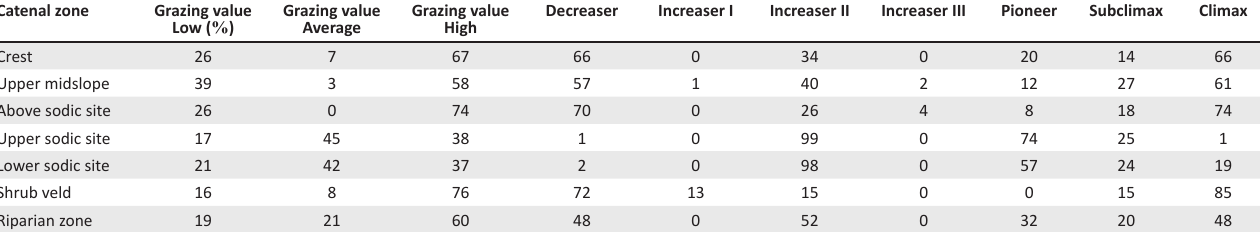
TABLE 3: Contribution ( % ) of grass species present on 100 m point method line to different categories for each catenal zone. Catenal zone